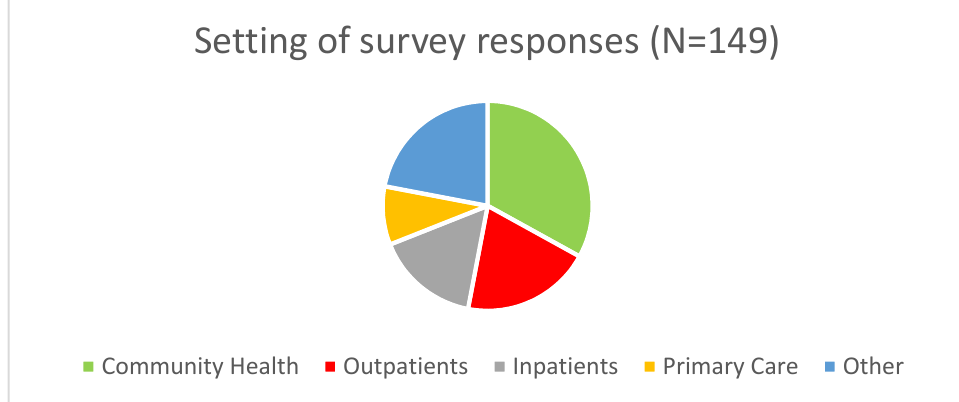
Figure 1. Survey responses received by area of work.